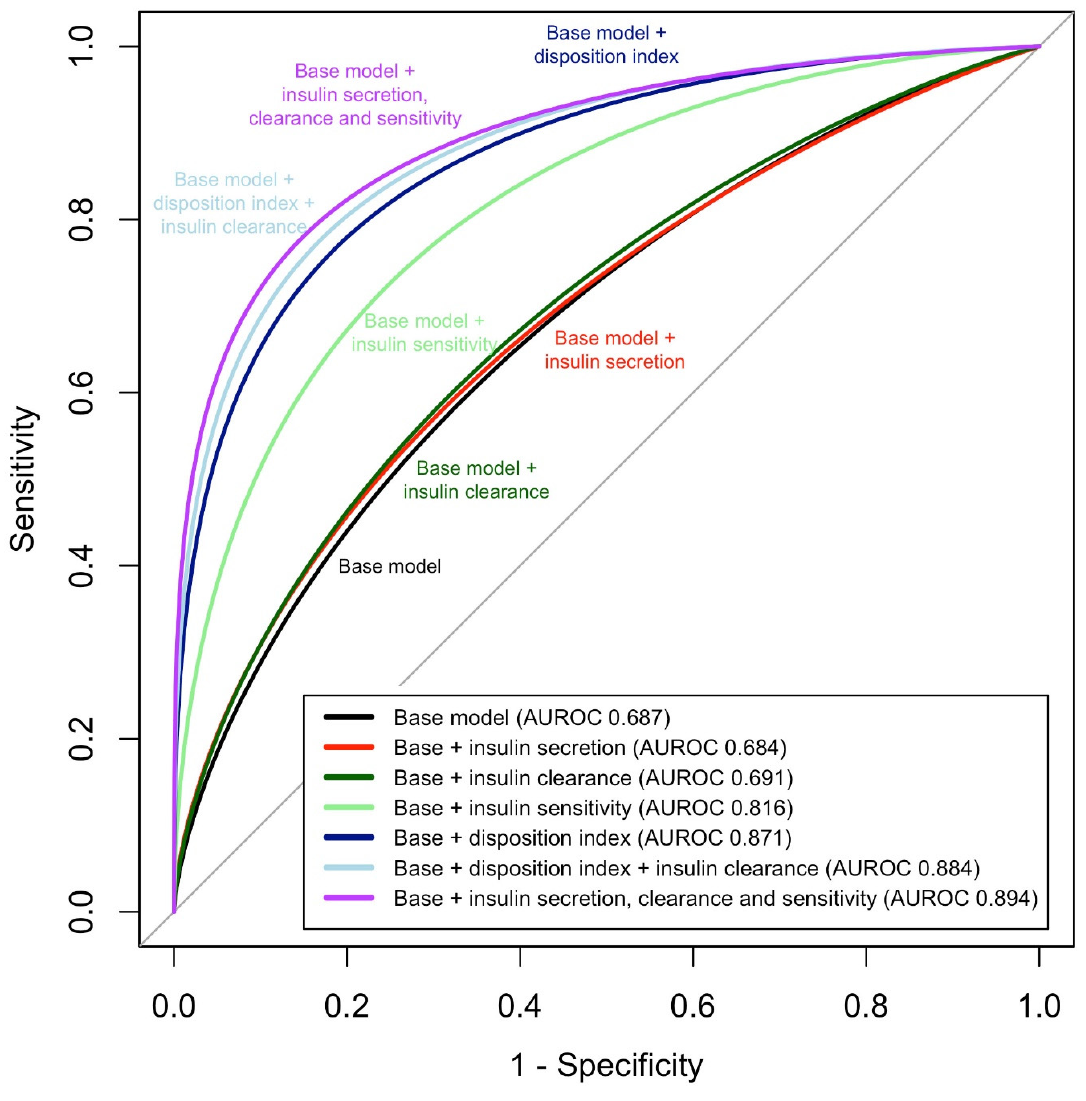
Figure 3. Area under the receiver operating characteristics curve (AUROC) for models examining the sensitivity and specificity of four insulin homeostasis traits to discriminate dysglycemia from normal glucose tolerance, in separate models and for models combining traits.